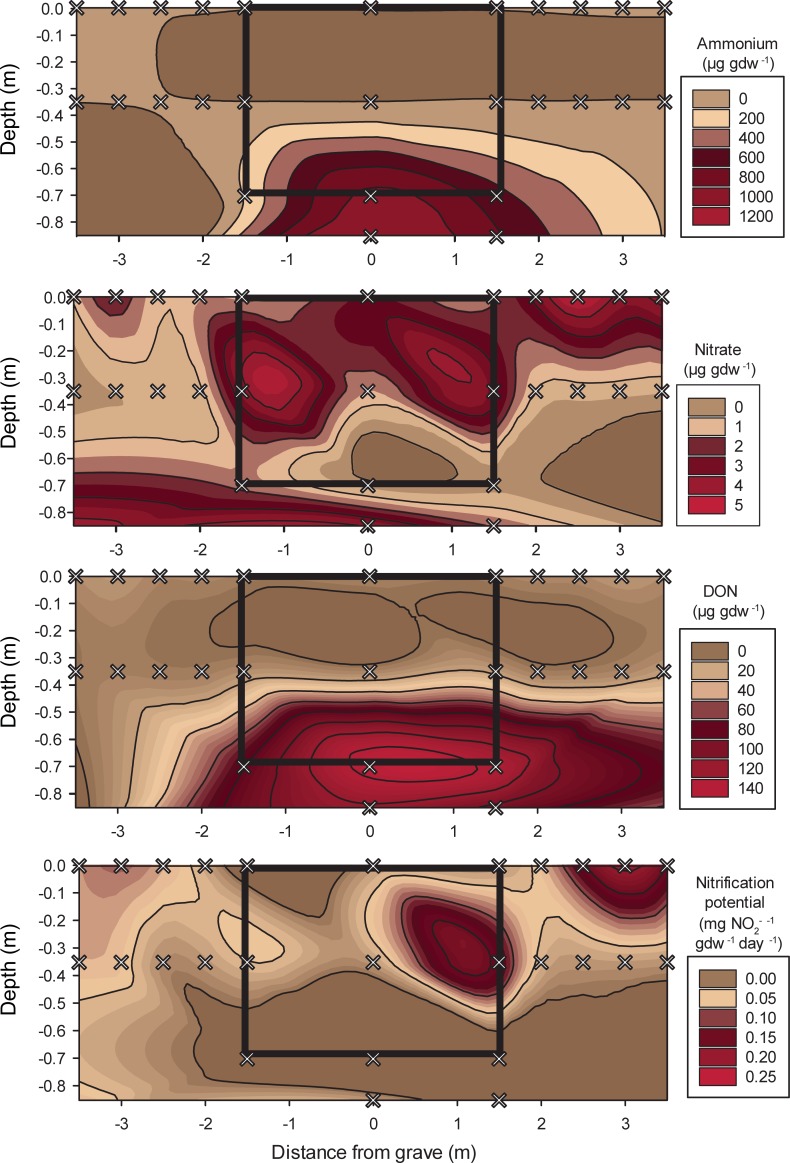
Cross-sectional contour maps of nitrogen concentrations or flux rates measured along lateral transects and within the multi‒individual grave.Grey x indicate soil sampling locations. The black box in each figure outlines the excavated area of the grave.